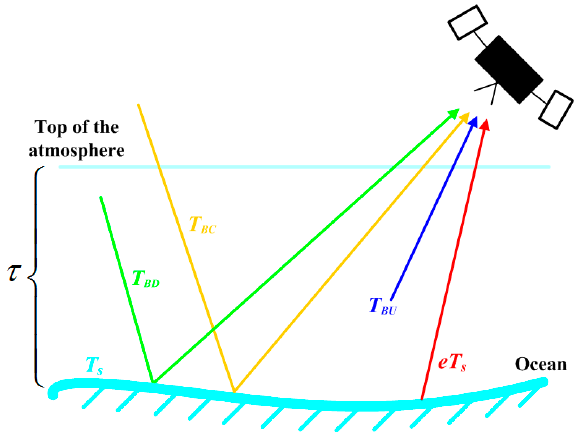
Figure 2. The brightness temperatures received by a radiometer.